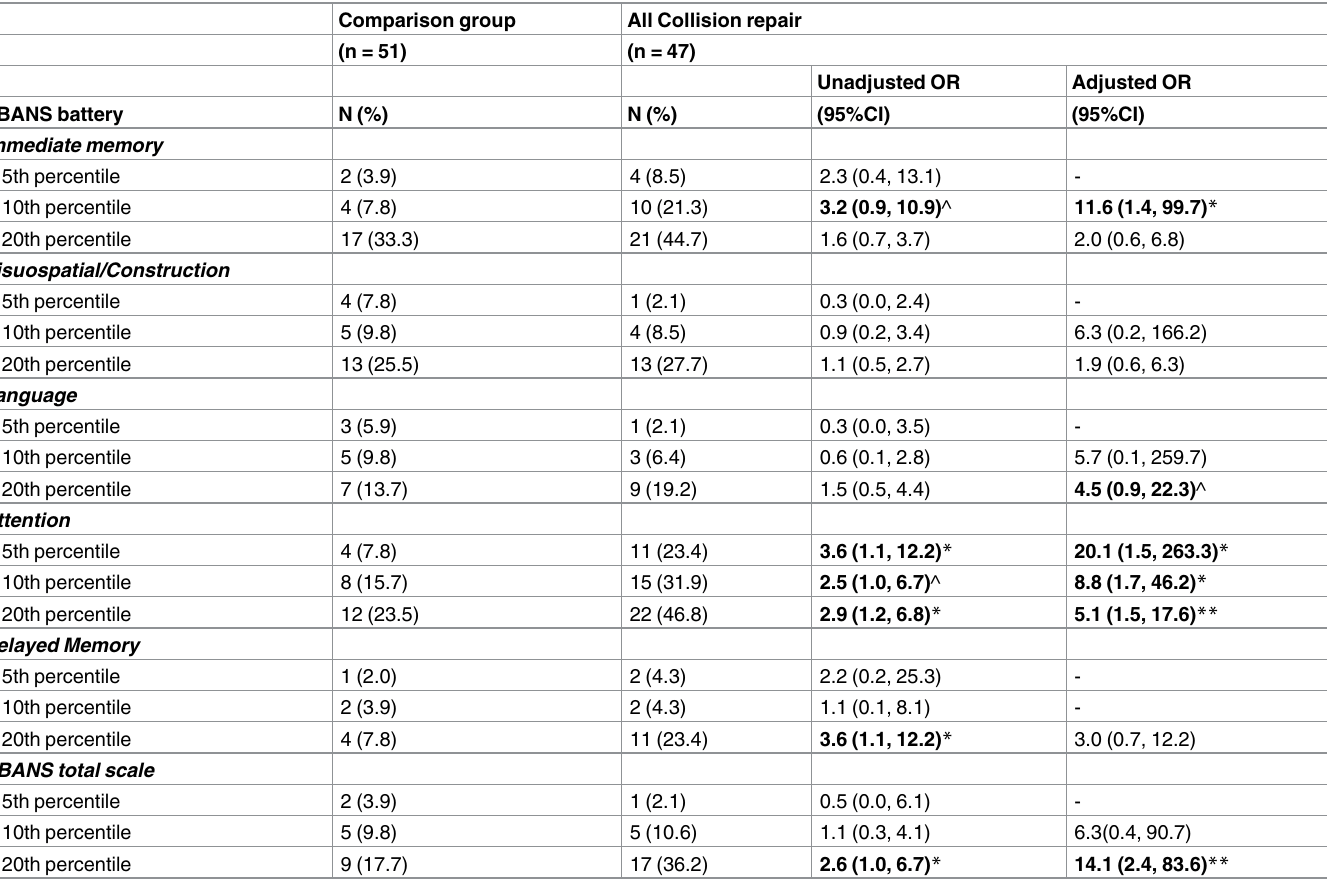
Table 3. Neuropsychological test scores based on the bottom 5 th , 10 th and 20 th percentiles for comparison and collision repair workers. Comparison